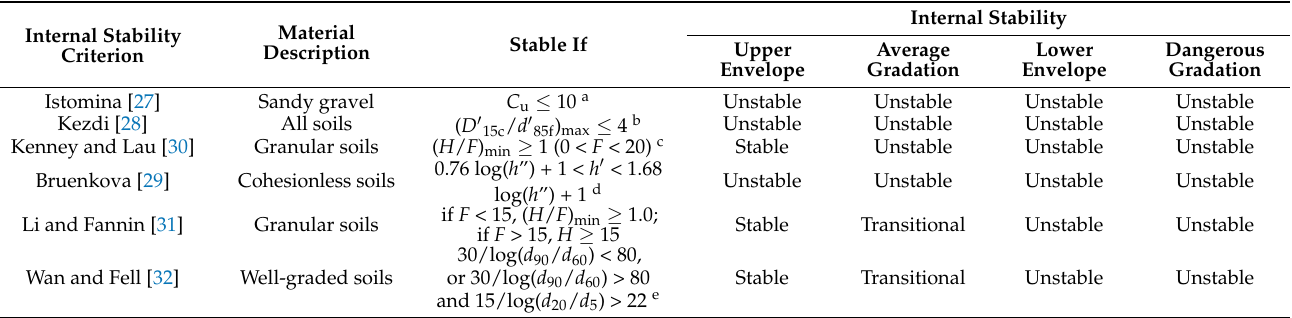
Table 1. Internal stability of the tested soil samples.